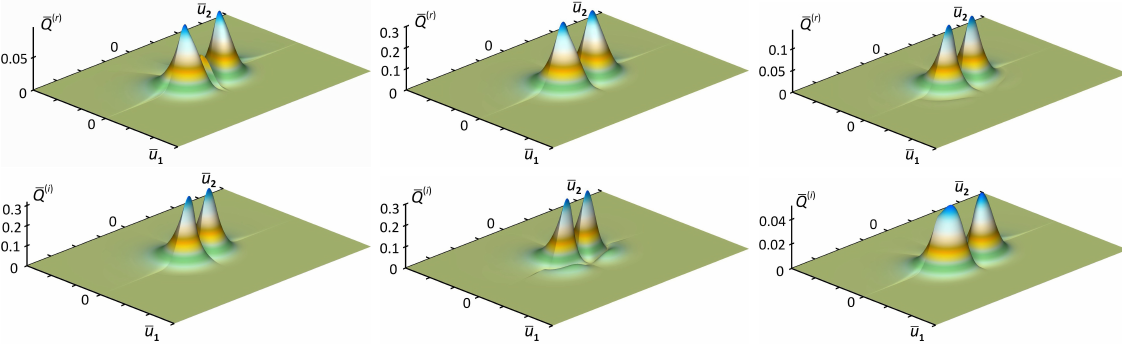
Figure 5. Distributions of the fields of the environment in the course of evolution, respectively, at the time points t 1 = 1.5, t 2 = 10 and t 3 = 20, calculated using the third line of the table.